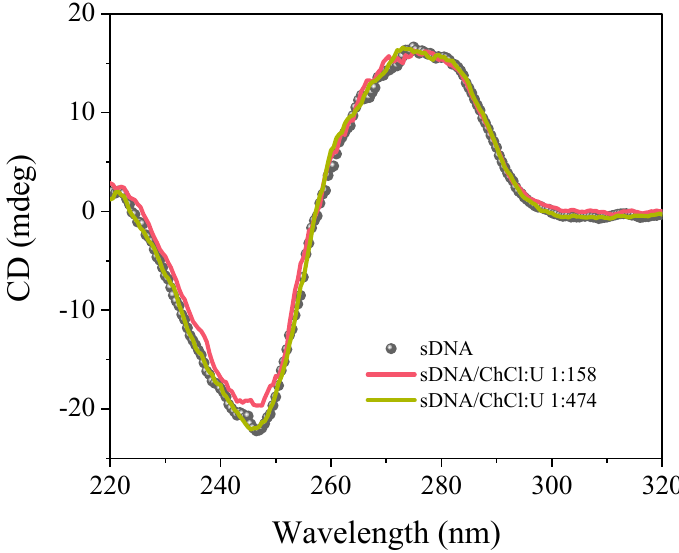
Figure 5. Comparison among the Circular Dichroism (CD) spectra collected at room temperature for sDNA and sDNA/ChCl:U (1:158 and 1:474).